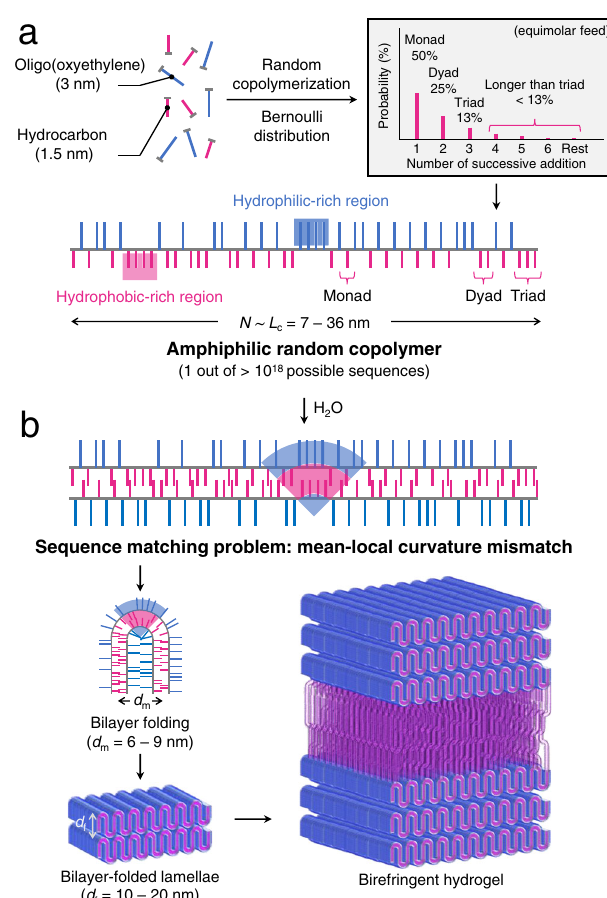
Fig. 1 Bilayer folding of an amphiphilic random copolymer in an aqueous solution. a The random copolymerization of monomers containing hydrophilic oligo(oxyethylene) and hydrophobic hydrocarbon groups yields an amphiphilic random copolymer. Theoretical sequence-length distribution of the hydrophobic groups along the polymer backbone is given for an equimolar feed 3 , and a hypothetical chain sequence out of many possible arrangements (exponential to N ) is depicted for N = 60. L c represents the contour length of the backbone, which is proportional to N . b The amphiphilic random copolymer self-assembles in water into a bilayer with an interlayer spacing of d m . The random sequence forces to generate numerous mismatches in local hydrophilic-phobic balance. A hinge will be generated by folding where the local curvature noticeably mismatches the mean packing parameter, and this results in the bilayer-folded lamella. They stack further with a spacing of d f , connecting the unfolded domains, and turning the whole solution into an anisotropic hydrogel. For simplicity, the bilayers in the folded domains are drawn to be defect-free following the adjacent reentry model in chain-folded